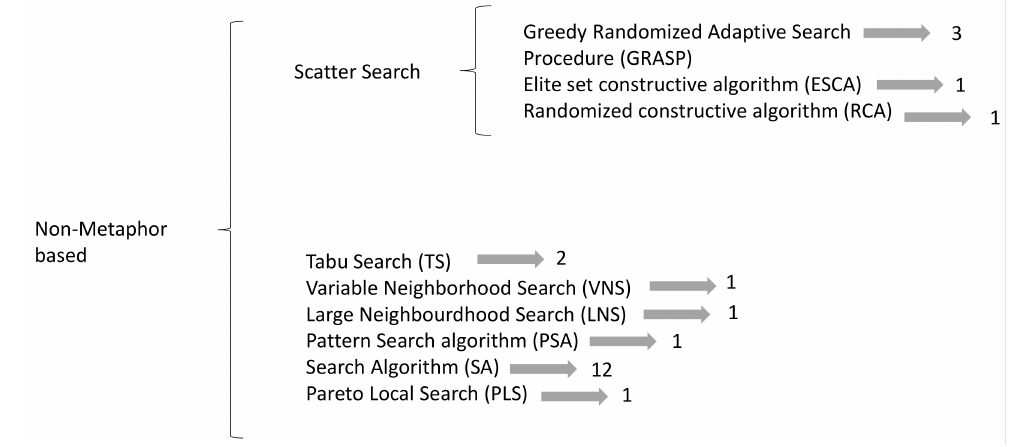
Figure 8. Non metaphor-based